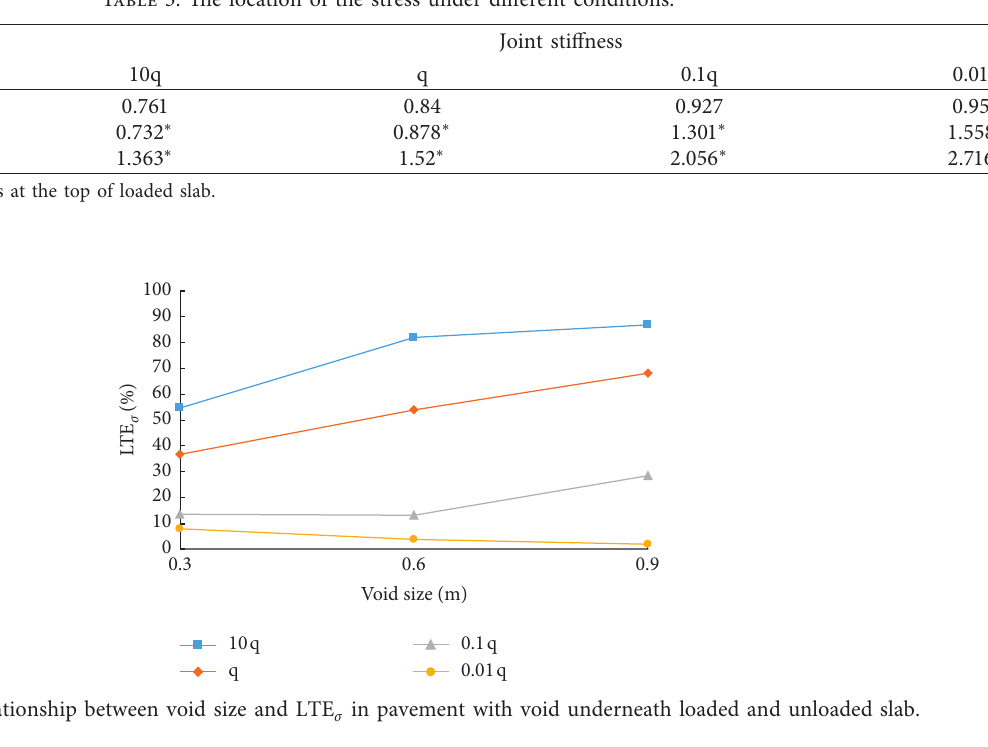
in pavement with void underneath loaded and unloaded σ